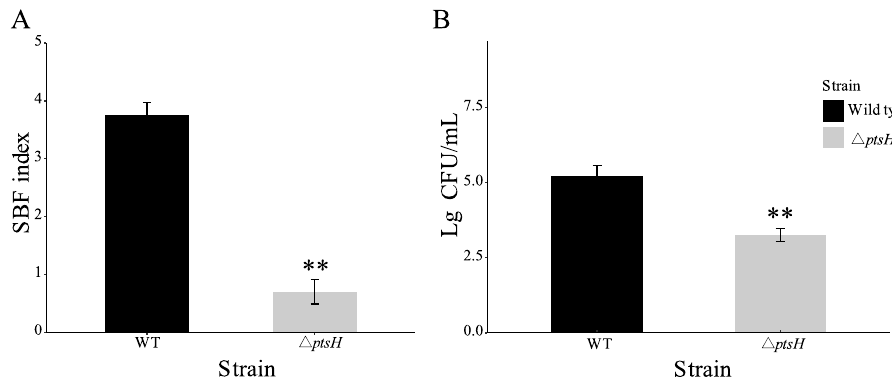
Figure 7. Effect of ptsH on biofilm formation ability ( A ) and adhesion to HT-29 cells ( B ) in C. sakazakii BAA-894. ** p < 0.01 compared to the WT strain.